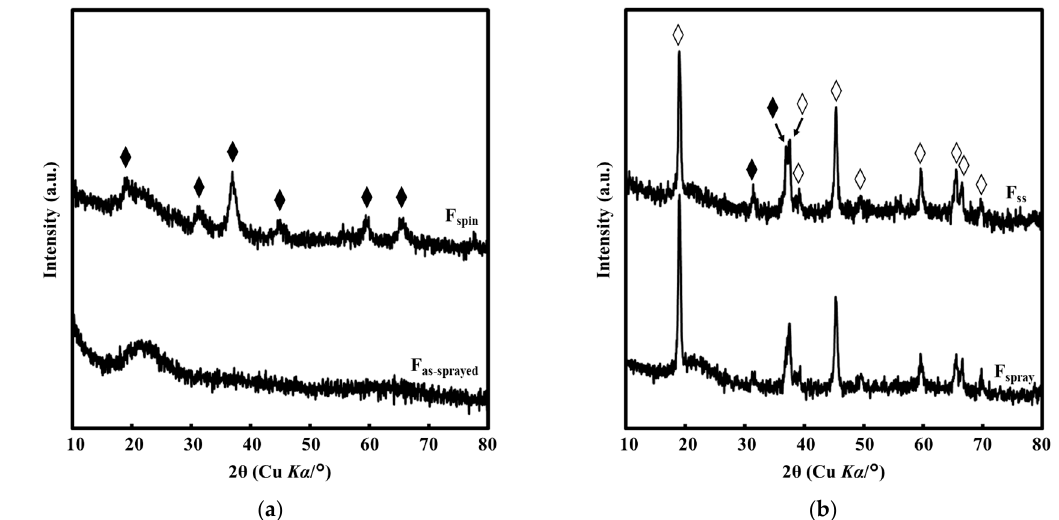
Figure 2. ( a ) X-ray diffraction (XRD) patterns of F as-sprayed and F spin . ( b ) XRD patterns of F spray and F ss . Peaks assignable to LCO and Co 3 O 4 are denoted by ♢ and ♦ , respectively.